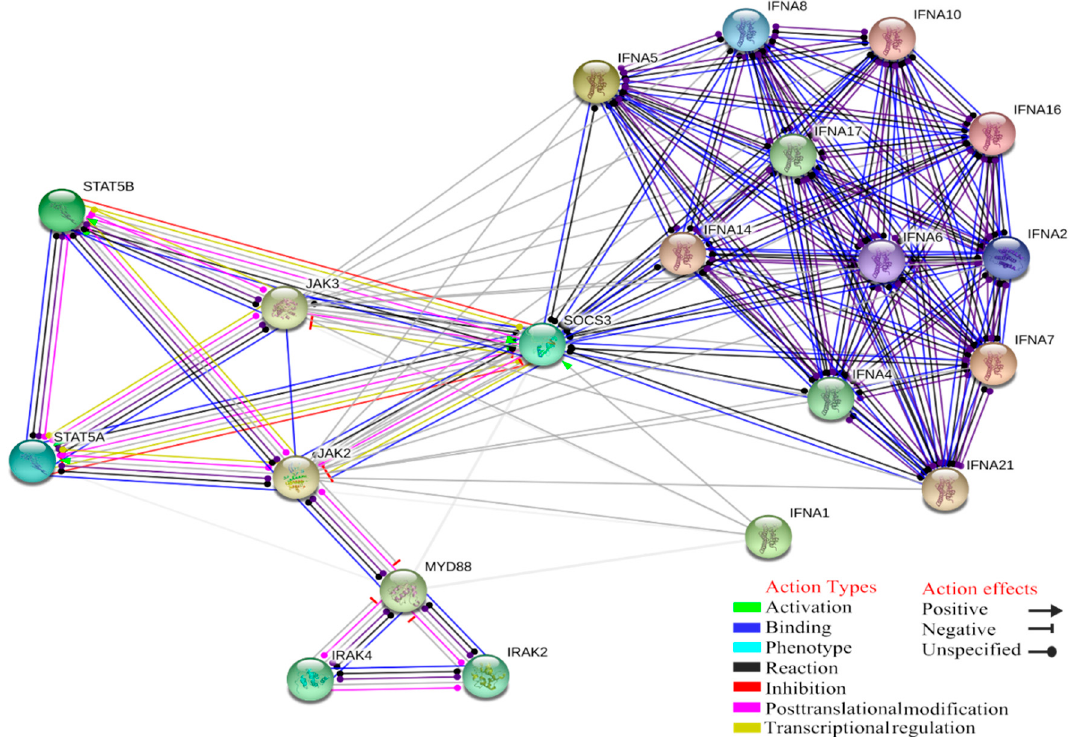
Figure 4. Interaction between MyD88 and JAK-STAT pathway, linked to IFN- α ; this interaction is mediated by suppressors of cytokine signalling 3, SOCS family proteins which are part of a classical negative feedback system regulating cytokine signal transduction.